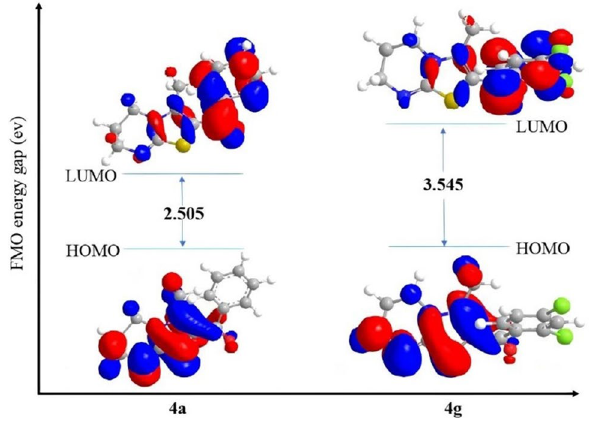
Figure 5. Frontier orbital and energy gap of frontier orbitals of compound 4a and 4g. The figure was generated using PerkinElmer Chem3D 15.0.0.106. (https:// perki nelmer- chemd raw- profe ssion al. softw are. infor mer. com/